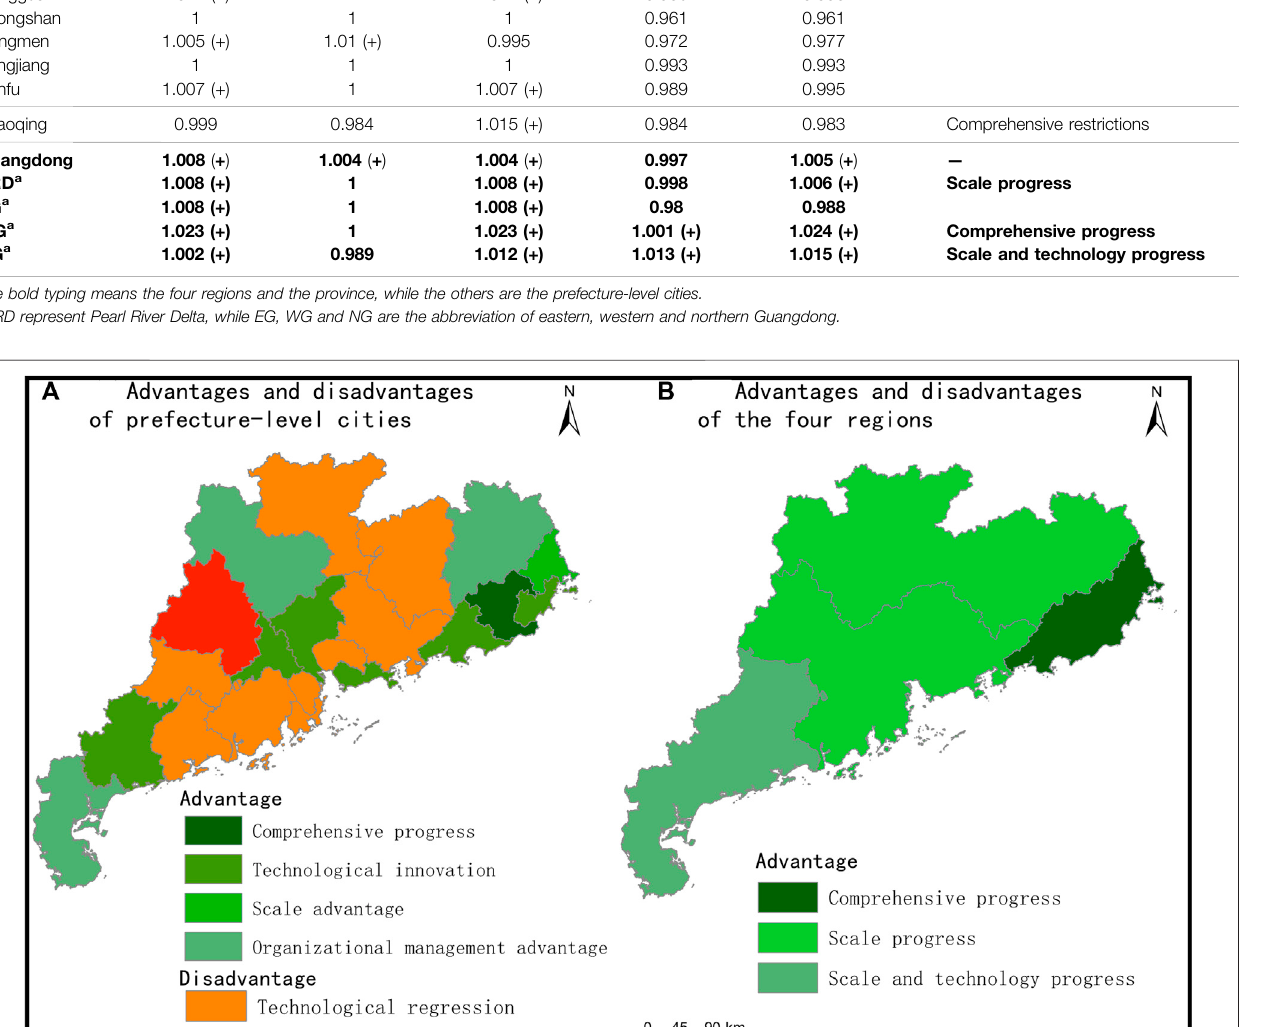
Frontiers in Environmental Science |